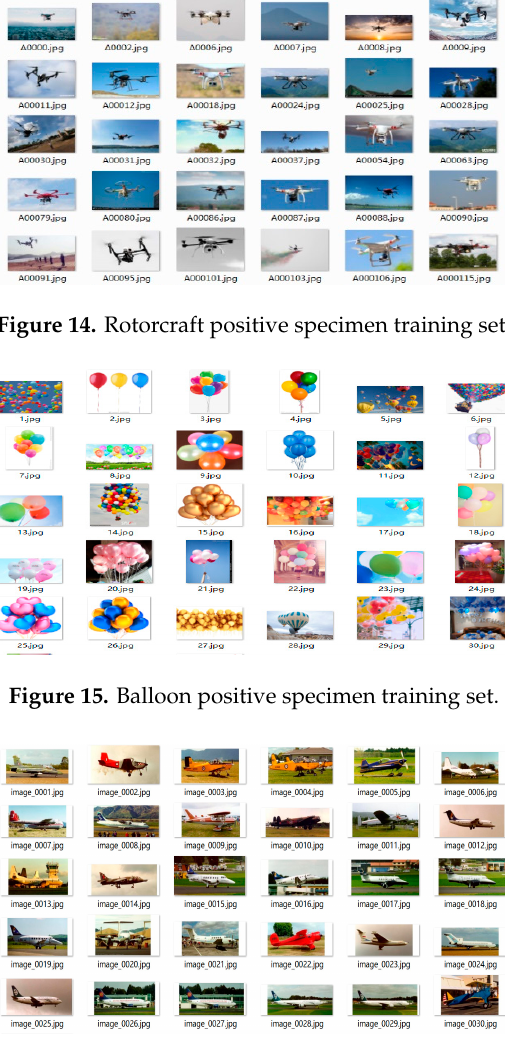
Figure 16. Fixed-wing aircraft positive specimen training set.